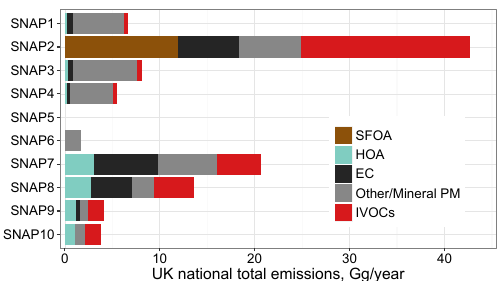
Figure 1. Annual UK PM 2 . 5 emissions by SNAP sector (Table 1) as specified in the NAEI (for year 2012), with each sector split into POA (HOA or SFOA), EC, and remaining PM following Kuenen et al. (2014). The red bars are additional IVOCs (not included in official emission totals) that can be estimated as 1.5 × the POA mass in that sector. They are included in this plot to give an indication of the relative mass of IVOC additions that have been used in other